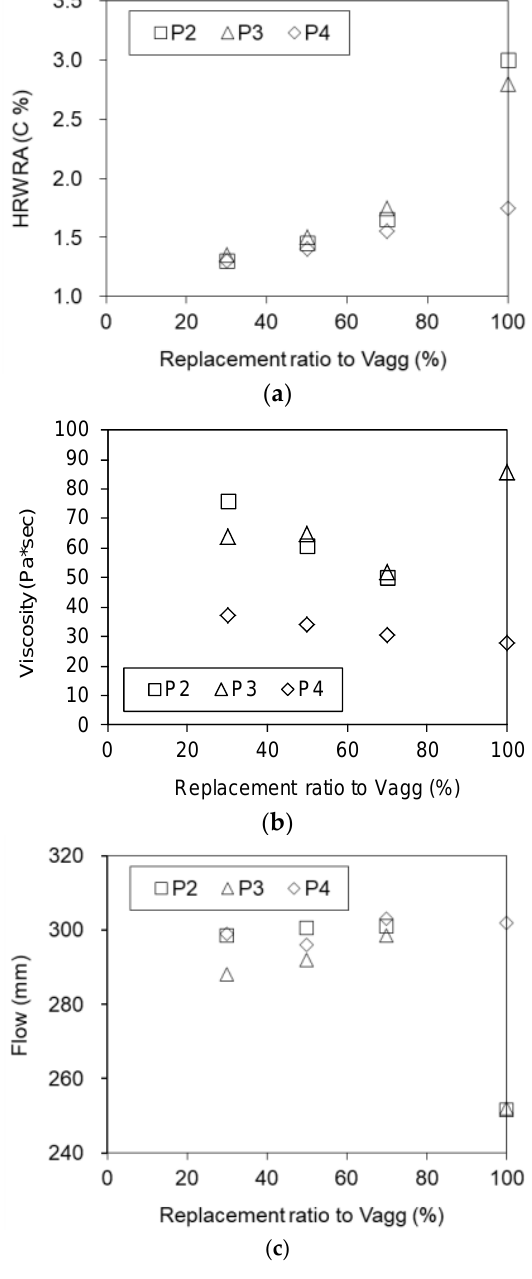
Figure 18. Effect of P2, P3, and P4 addition ratios to Vagg. ( a ) HRWRA. ( b ) Viscosity. ( c ) Mortar flow.